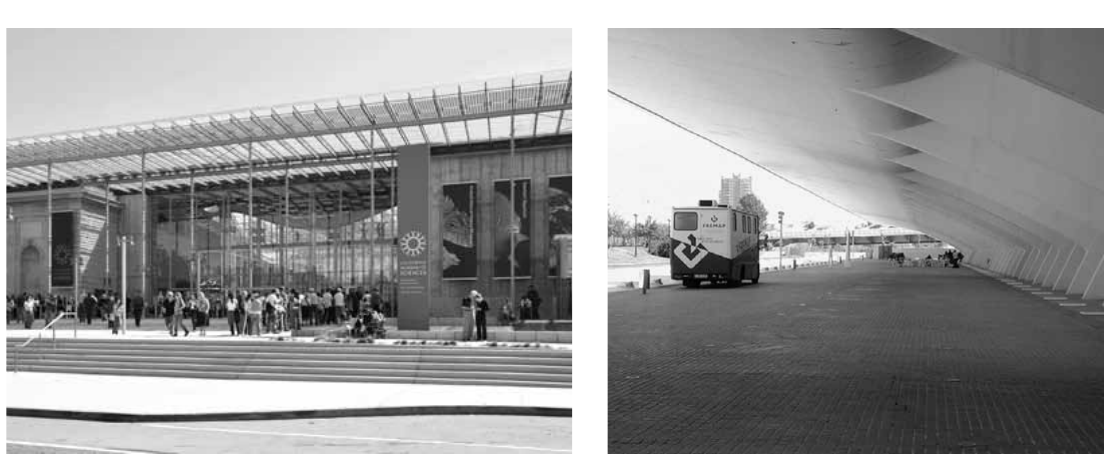
fig. 1. California academy of Sciences fig. 2. City of arts and